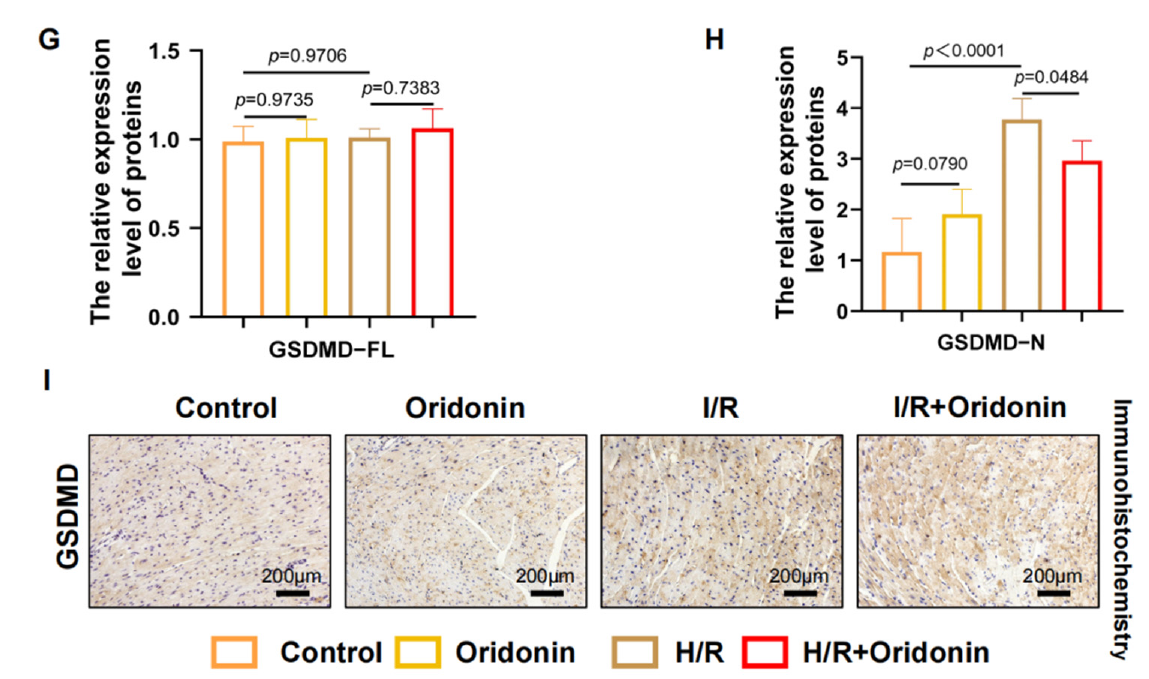
Figure 2. Oridonin reduces IR-induced myocardial pyroptosis in vivo. ( A ) The LDH content in the serum from each group. ( B ) The content of CK-MB in serum from each group. ( C ) The content of IL-1 β in serum from each group. ( D ) The content of IL-18 in serum from each group. ( E ) Typical western blot of GSDMD-FL, GSDMD-N, and cleave-caspase-1 from each group. ( F ) Densitometric quantification of cleave-caspase-1 based on ( E ). ( G ) Densitometric quantification of GSDMD-FL based on ( E ). ( H ) Densitometric quantification of GSDMD-N based on ( E ). ( I ) Representative immunohisto- chemistry results from each group. The protein level was standardized using GAPDH. All samples were obtained from C57BL/6 mice. In all cases, the data are expressed as the mean ± SD.